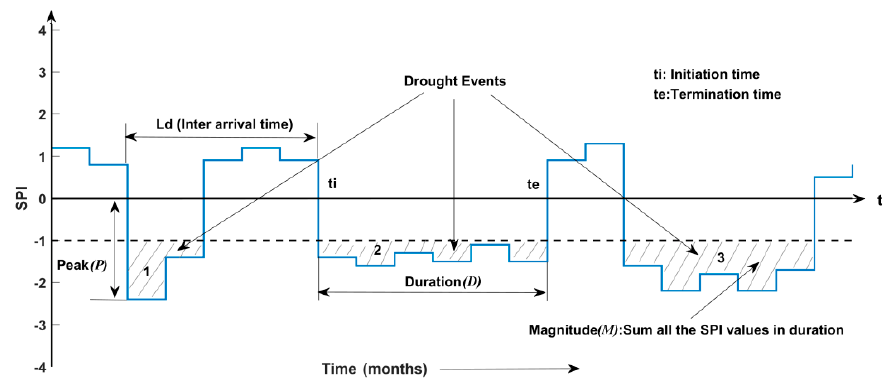
Figure 2. Sketch of drought characteristics using the SPI.